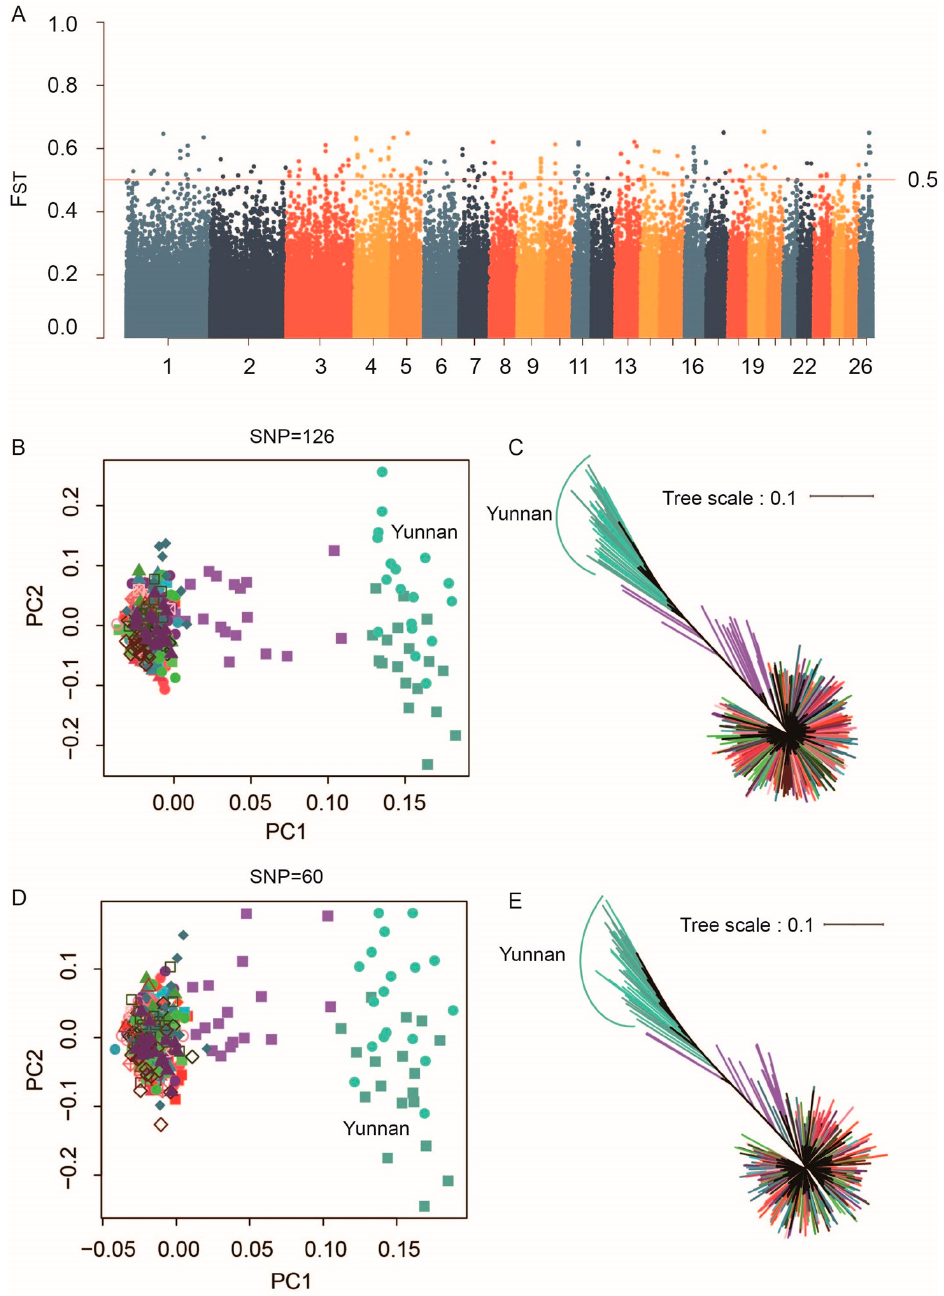
Figure 4. Construction of specific SNP genetic marker sets in Yunnan Tibetan sheep. ( A ) Genome- wide distribution of FST values in Yunnan Tibetan sheep (Jianchuan (JC) and Ninglang (NL) sheep). The significance threshold of selection signature was set to 0.5 for each individual test and is indicated with red horizontal full lines. ( B ) PCA and ( C ) NJ tree analysis of 126 SNPs distinguishing sheep from Yunnan (JC and NL). ( D ) PCA and ( E ) NJ tree analysis of 60 SNPs distinguishing sheep from Yunnan (JC, Jianchuan, and NL, Ninglang). The cyan solid square and circle represent JC and NL sheep in PCA plots, respectively. The color of JC and NL sheep in the NJ tree was the same as that in the PCA